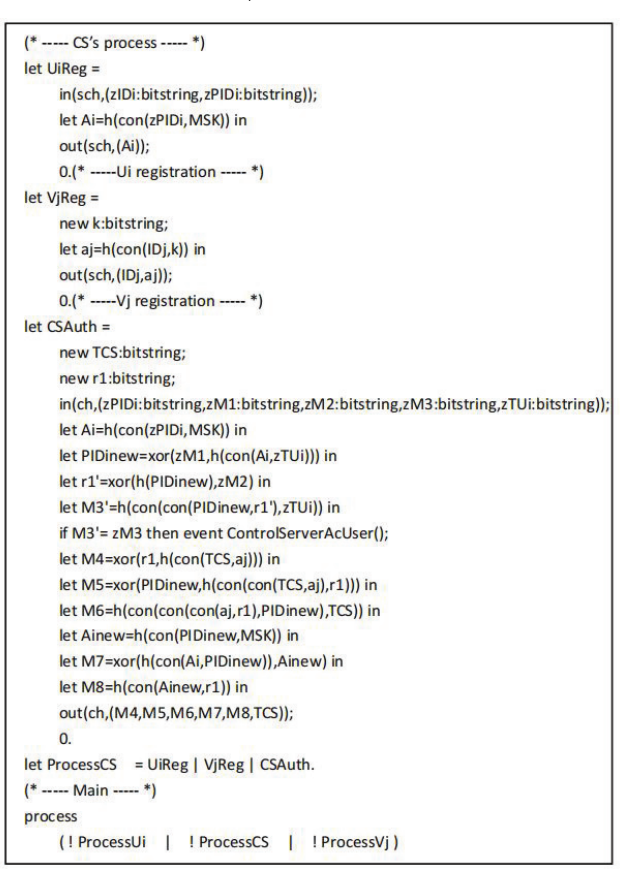
Figure 9. The process of CS